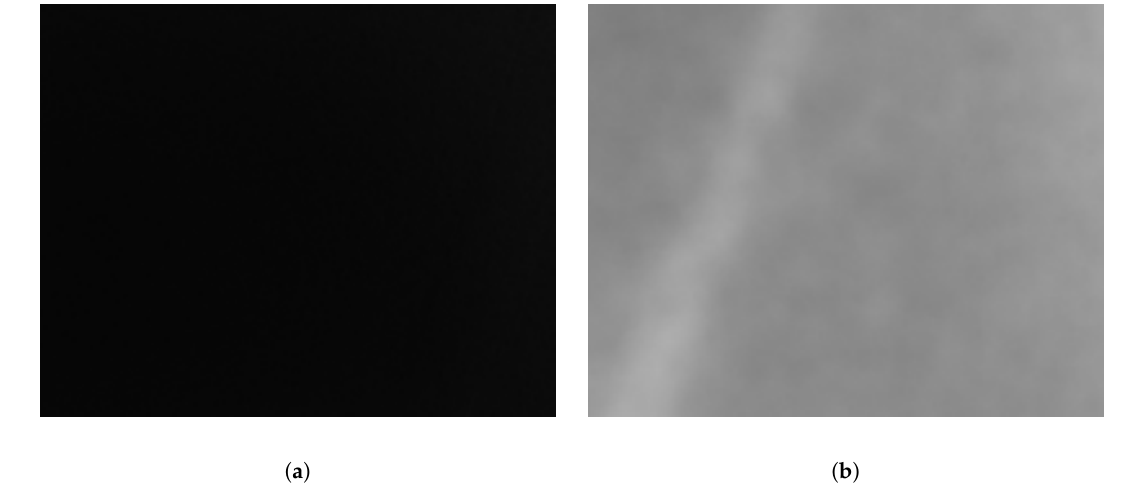
Figure 6. Example of a wood defect in a dark color melamine faced panel. In the visible spectrum the defect cannot be appreciated, while in the LWIR spectrum it can be easily detected (the defect is the white rectangle with a slope at the left of the image) (( a ) VS spectrum, ( b ) LWIR spectrum).